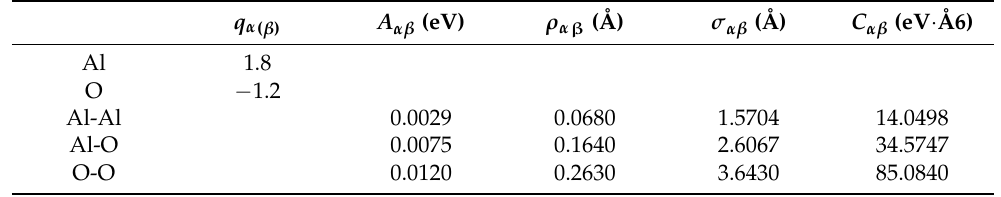
Figure 1. Snapshots of the considered configurations in this study at the temperatures of 2500 K, 3000 K, 3500 K, and 4000 K, with three different densities at each temperature (the blue particles: Al atoms, the red particles: O atoms). Table 1. Potential parameters for liquid alumina